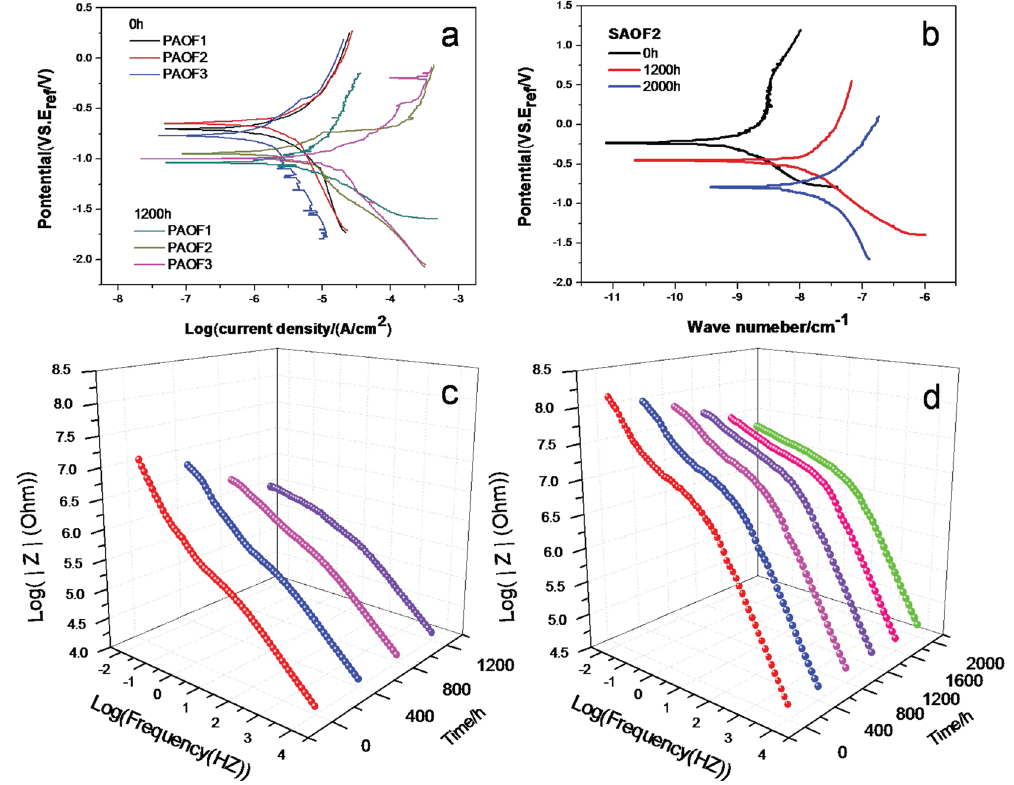
Figure 5. Potentiodynamic polarization, ( a ) (SAOF), ( b ) (PAOF) and impedance modulus of samples changed with SST time, ( c ) (SAOF), ( d ) (PAOF).